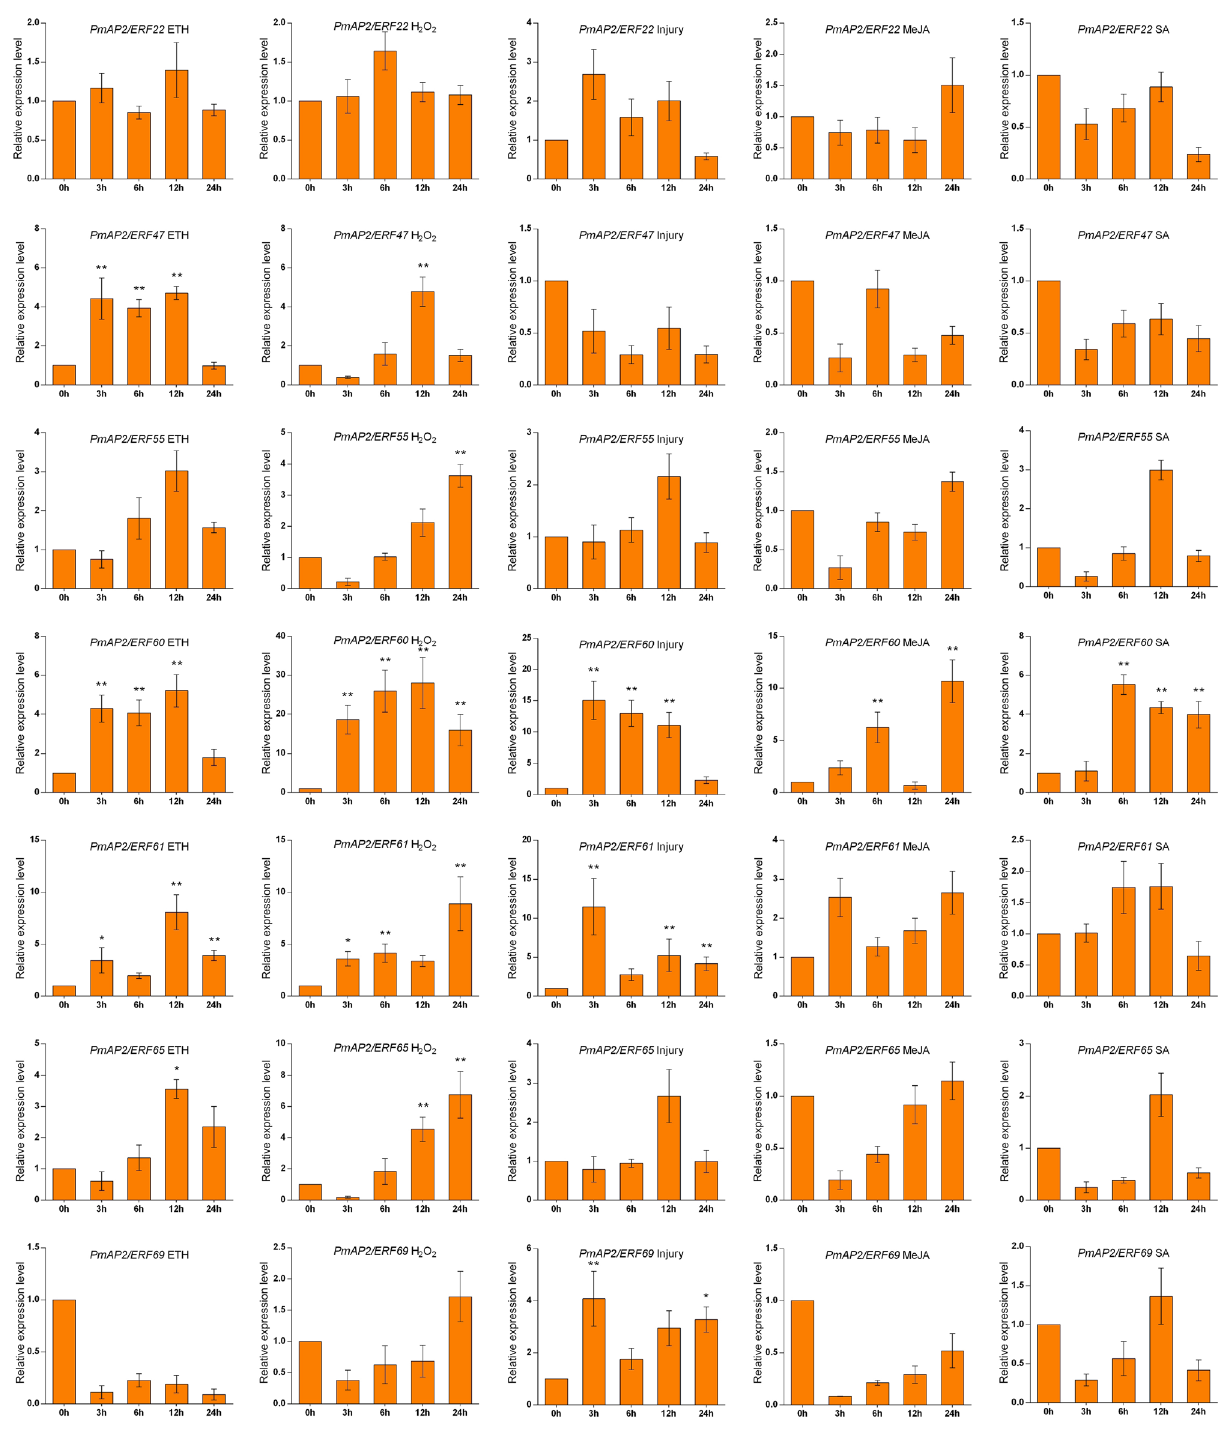
Figure 6. Expression of AP2 / ERF genes in response to different treatments related to pine wood nematode infection in vitro. The asterisks indicate stress the treatment groups that significantly differed with respect to transcript abundance compared with that of the control group (*p < 0.05, **p <